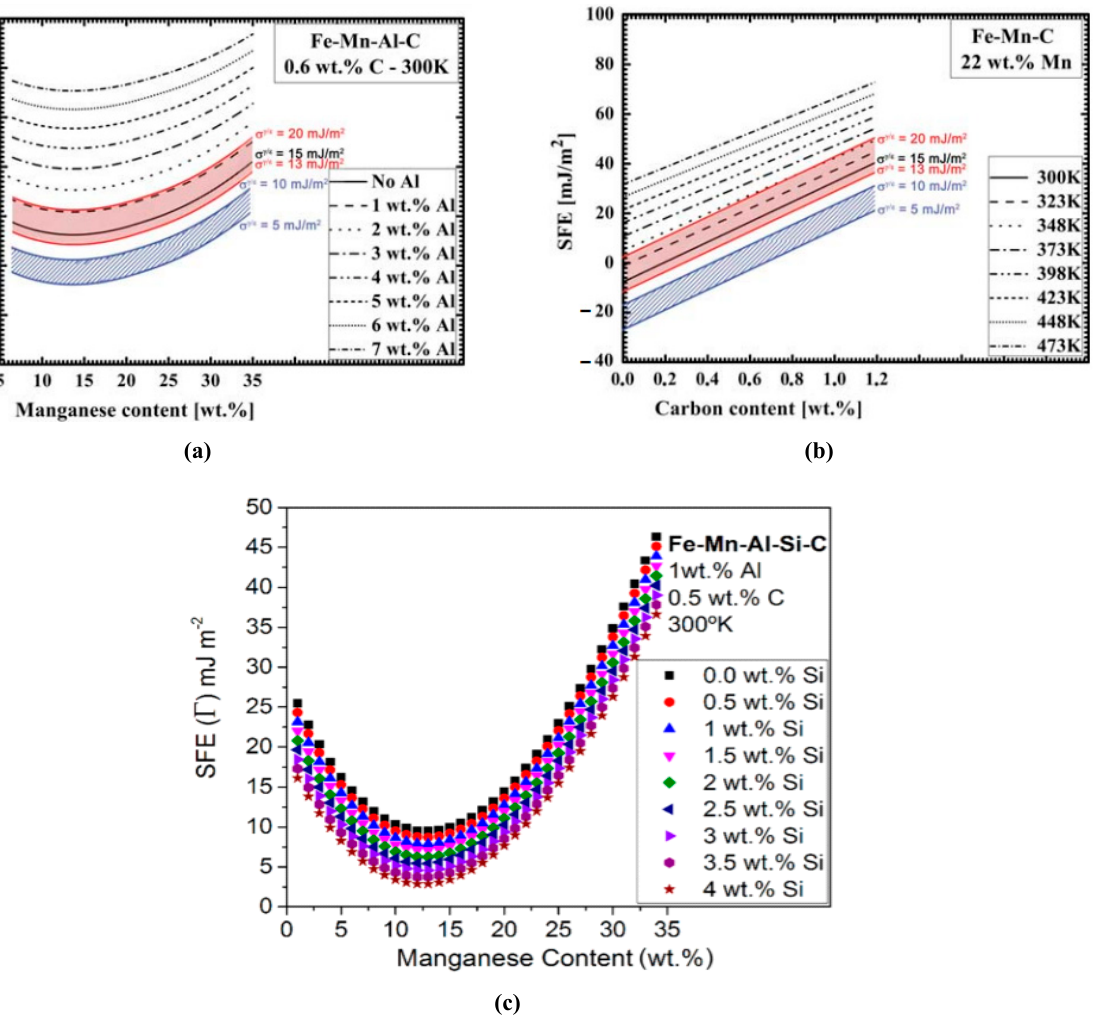
Figure 14. Composition-dependent SFE maps. ( a ) The influence of Mn and Al contents on SFE in a steel with 0.6% C [71]. Adapted from [71], with permission from Springer, 2023. ( b ) The influence of C content on the SFE in a steel with 22% Mn [71]. ( c ) The influence of Mn and Si on the SFE in a 0.5% C steel with 1% Al [64]. Adapted from [64], with permission from ASME Publications, 2023.